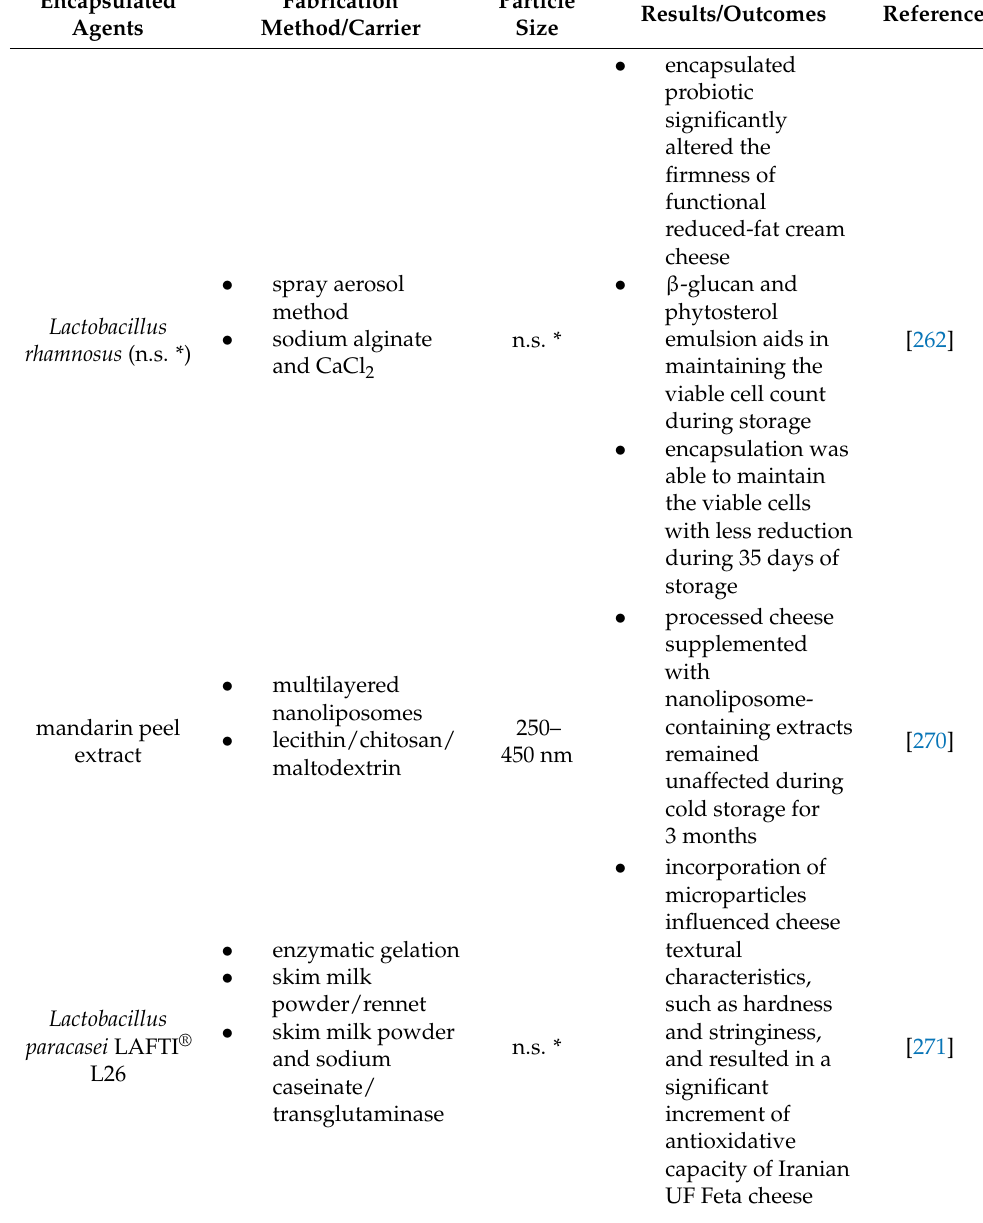
Table 6. Cont. Encapsulated Agents